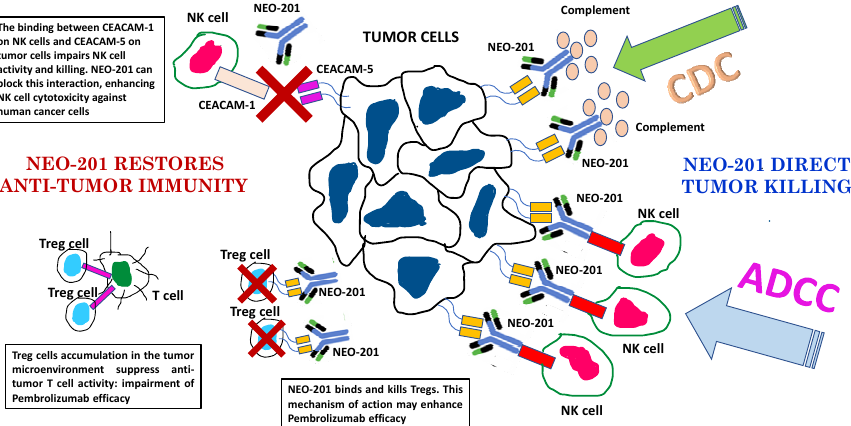
Figure 4. Mechanisms of action of NEO-201 and rationale to combination therapy with pembrolizumab. ADCC: antibody-dependent cell-mediated cytotoxicity. CDC: complement dependent cytotoxicity. Although the majority of cancer patients treated with PD-1/PD-L1 blockade monotherapies do not achieve objective responses, when responses are observed, most tumor regressions are partial rather than complete [68]. The low response rates and resistance to PD-1/PD-L1 blockade could be due to the activity of regulatory T cells in the TME [69–71].